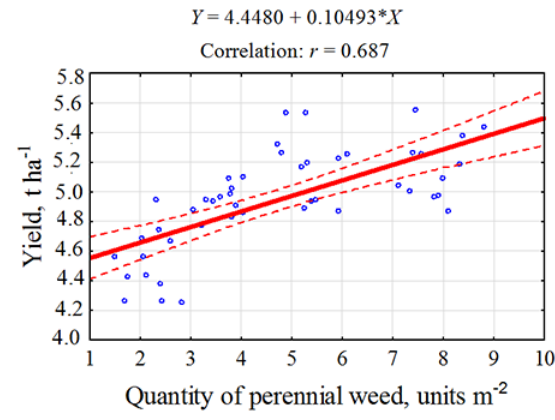
Figure 3 Linear regression graph of weed infestation of a winter wheat canopy cultivar, ‘Kryzhynka,’ under the mixture of herbicides and 4R Foliar concentrate treatment.